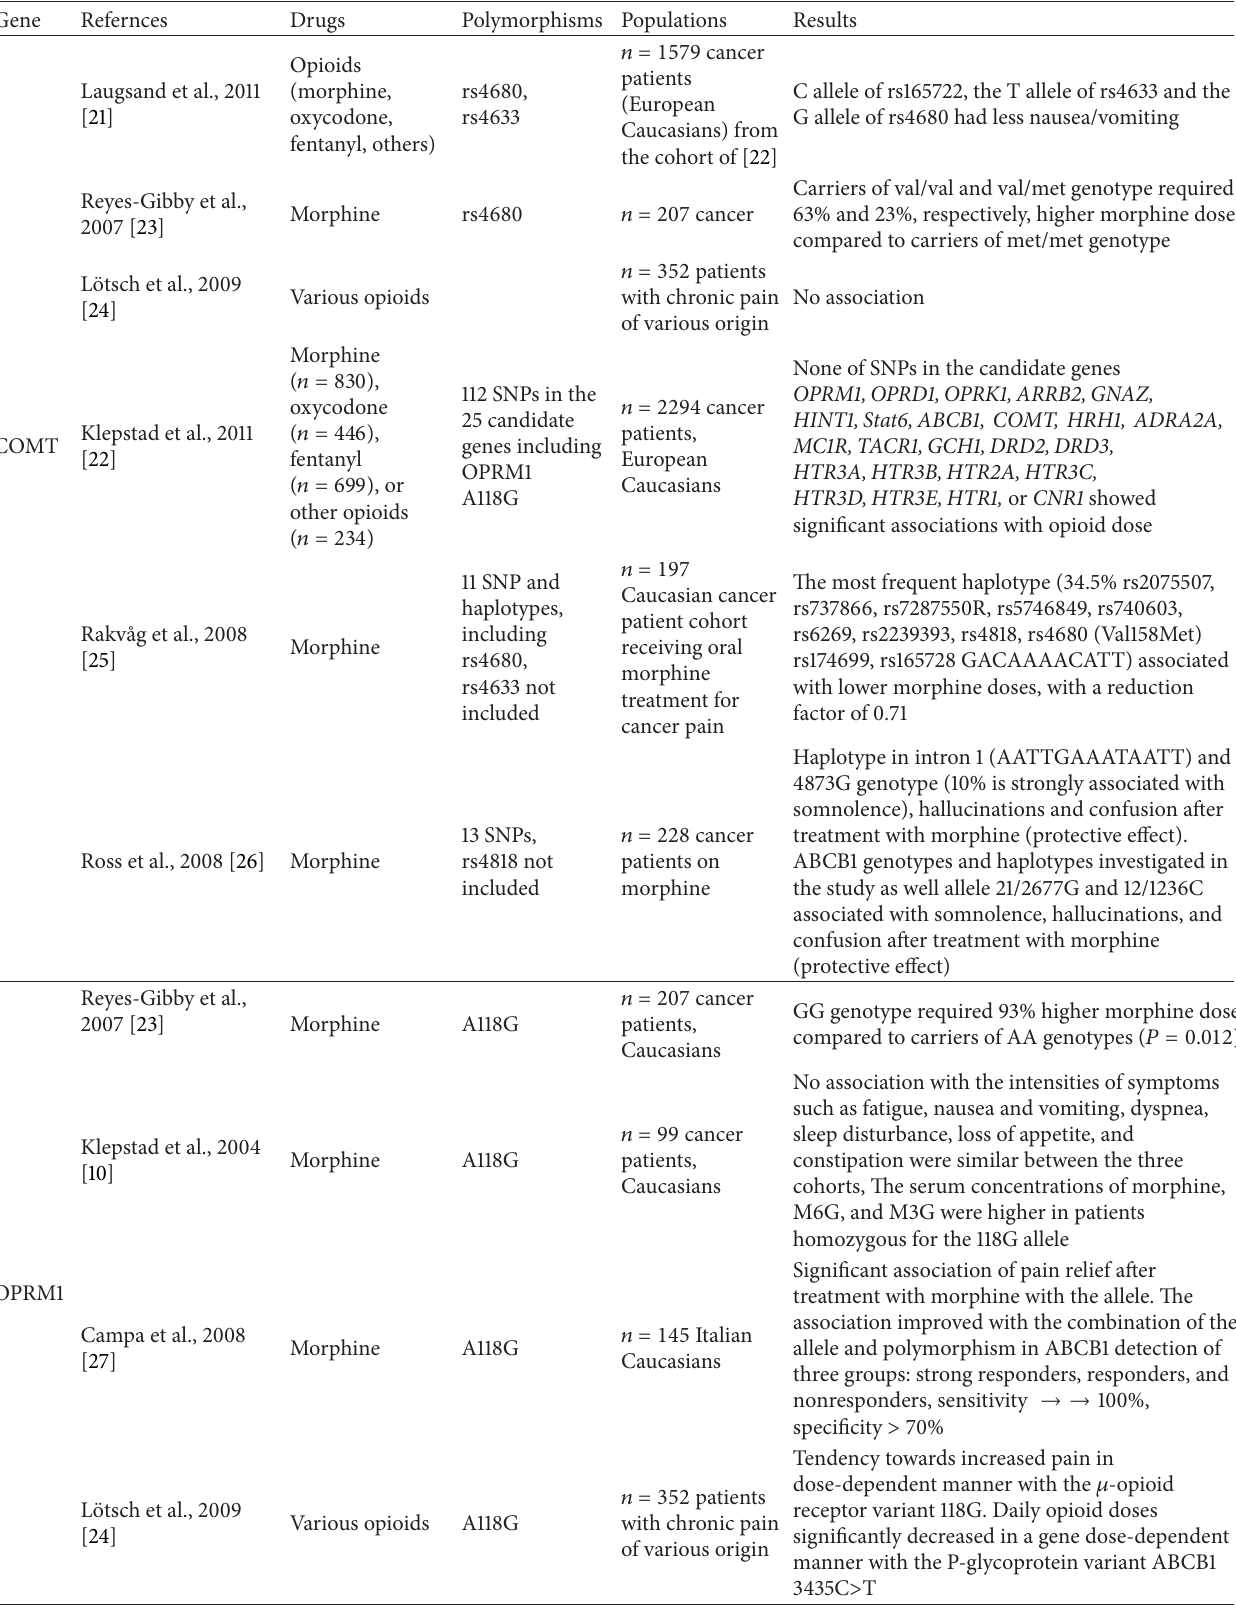
Table 2: Trials assessing the influence of gene polymorphisms associated with neurotransmission on drug response in humans.